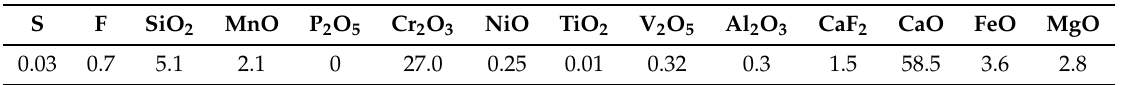
Table 2. A typical X-ray fluorescence (XRF) chemical composition for slags including all analyzed elements (mass%).